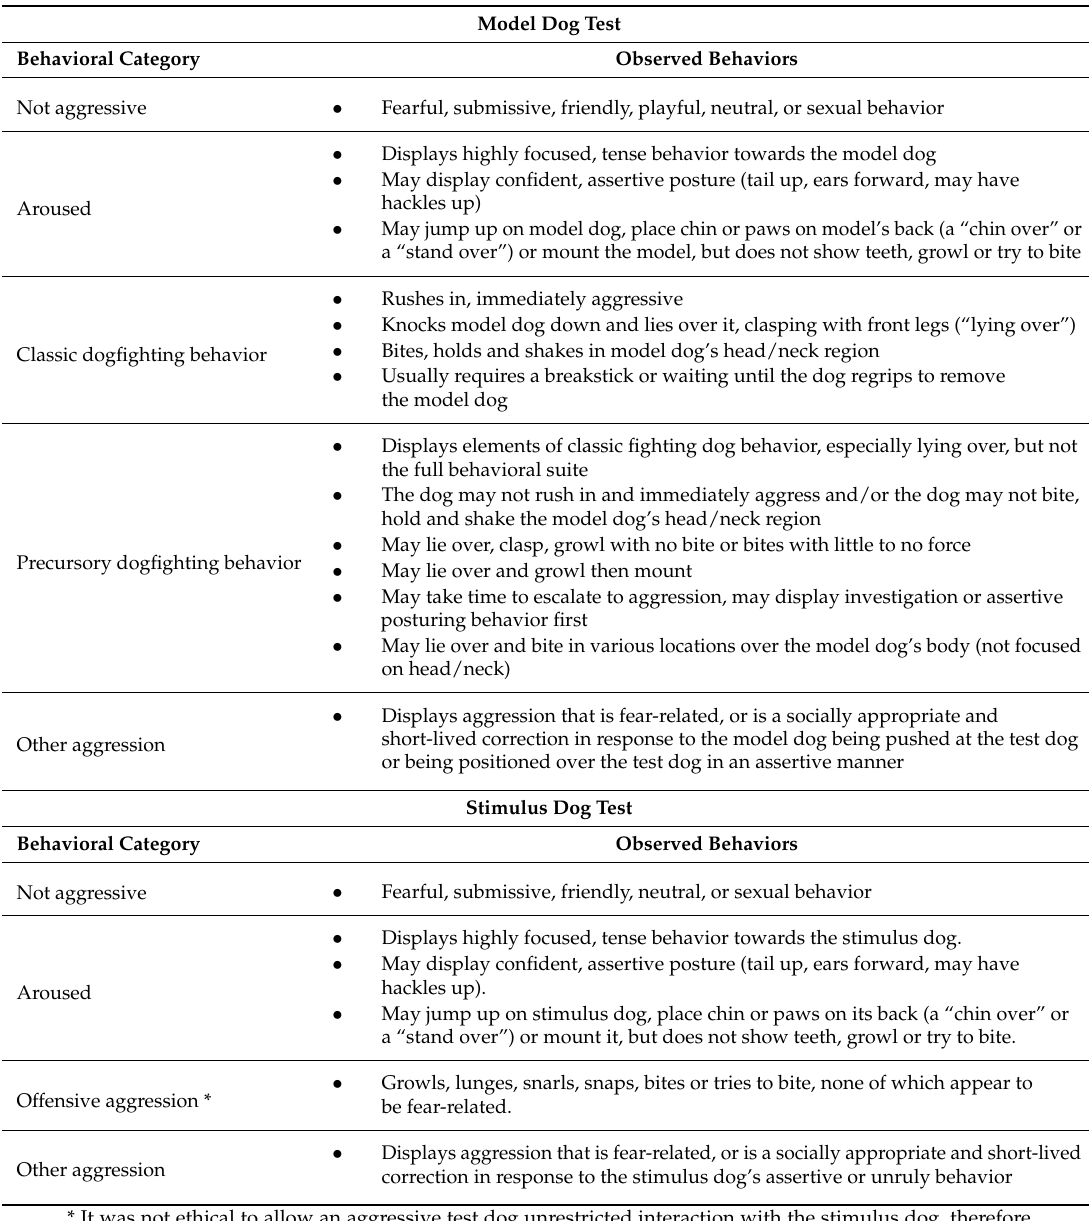
Table 1. Definitions of behavioral categories recorded during the model dog and stimulus dog tests in the behavior evaluation. If the test dog displayed classic dogfighting behavior to the model dog, that behavior was recorded and testing was ended. Otherwise, the test dog was introduced to the stimulus dog and behavior with the stimulus dog was